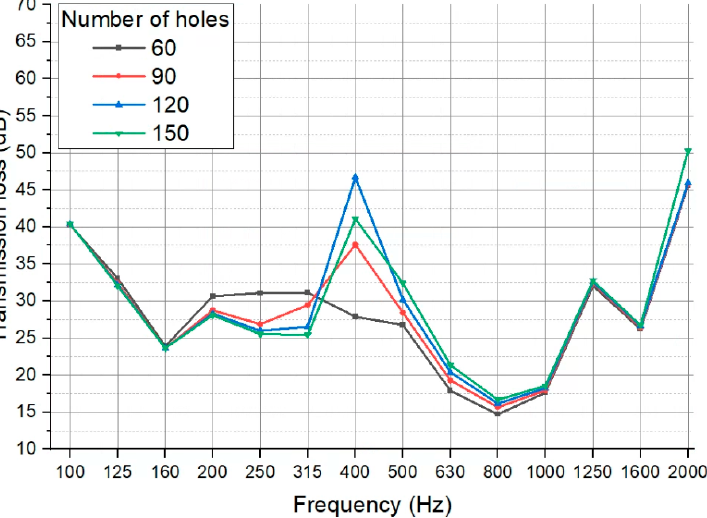
Figure 28. Transmission loss according to the variation of the number of holes in the outer resonate type.